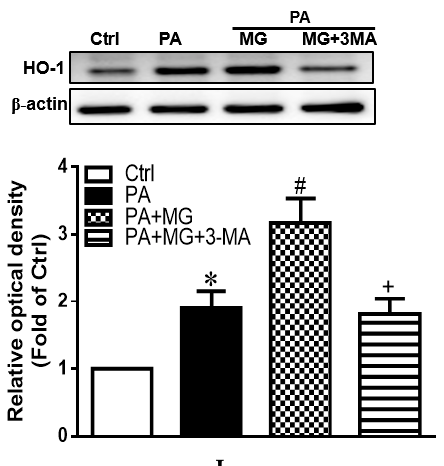
Figure 7. Effects of autophagy inhibitor 3-methyladenine (3-MA) in PA-induced steatosis of HepG2 cells. Cells were treated with MG in the presence or absence of 3-MA (5 mM) for 6 h, followed by treatment with PA (0.3 mM) for another 24 h. ( A ) Colorimetric assay for Oil Red O quantification; ( B ) triglyceride levels of the supernatant fraction; ( C ) representative Western blot and densitometry analysis of SREBP-1c and ATGL; ( D ) relative mRNA expression of lipogenesis markers Srebp-1 , Fas , Acc , Scd , and Cd36 ; ( E ) relative mRNA expression of lipolysis markers Hsl, Mgl, and Atgl; ( F ) reactive oxygen species were measured by dihydroethidium (DHE) Assay; ( G ) IL-1 β protein levels in the supernatant fraction; ( H ) representative Western blot and densitometry analysis of NLRP3, LC3B, and ATG7; ( I ) representative Western blot and densitometry analysis of HO-1. Data are expressed as mean ± SEM, n = 4. * p < 0.05 vs. Ctrl; # p < 0.05 vs. PA (palmitic acid); + p < 0.05 vs. MG (magnolol).